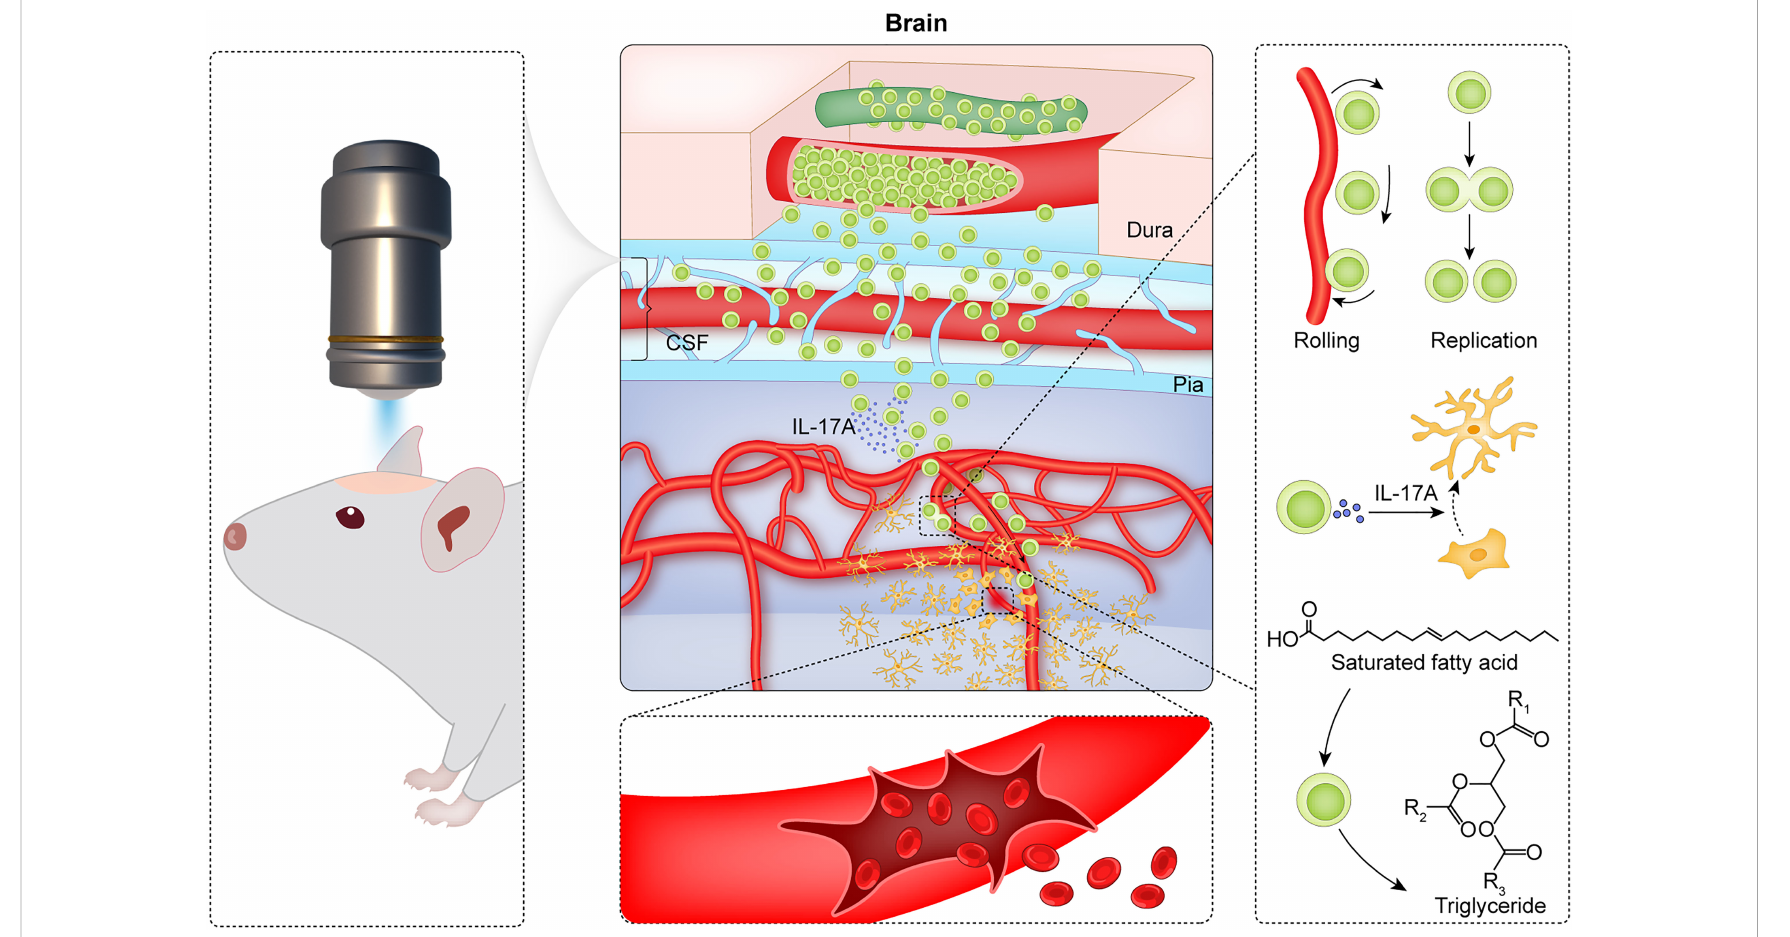
FIGURE 7 Summary of CMBs-induced gd T cells in the brain parenchyma. Using a two-photon microscopy, a spot injury of the microvessel is made to mimic a model of CMBs, and the dynamic behaviors of gd T cells are monitored. After CMBs, gd T cells are recruited to the peri-CMBs brain parenchyma from the dural blood vessels and proliferate locally with an elevated lipid metabolism. gd T cells secret IL-17A and play the roles of anti-neuroin fl ammation and neuroprotection at early stage of